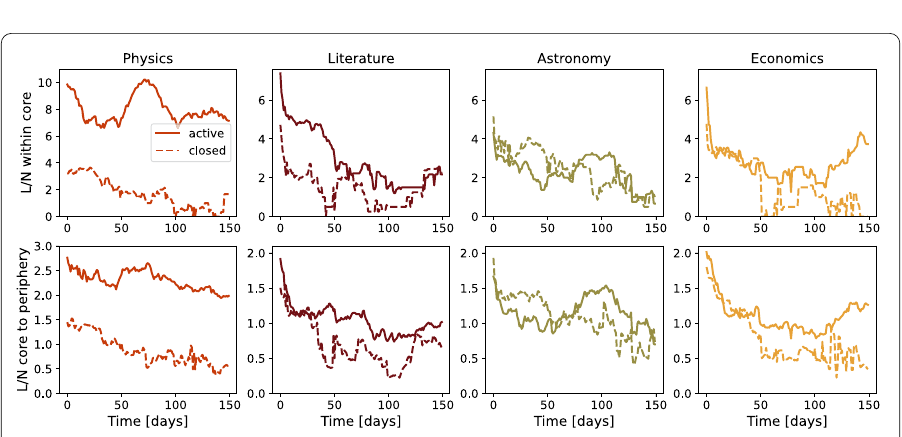
Figure 4 Connectivity among users within the core and between core and periphery. Links per node in core - top panel and links per node between core and periphery - bottom panel for the four pairs of Stack Exchange websites: Astronomy, Literature, Economics, and Physics. Solid lines – active sites; dashed lines – closed